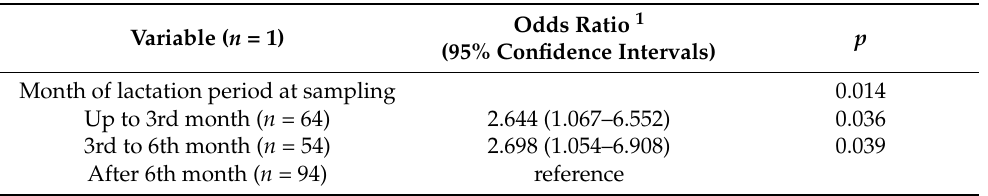
Table 4. Results of the multivariable analysis for increased total bacterial (>1500 × 10 3 cells mL − 1 ) in the bulk-tank milk of sheep flocks in Greece (mixed effects logistic regression and analysis with only flocks with the six most frequently recorded